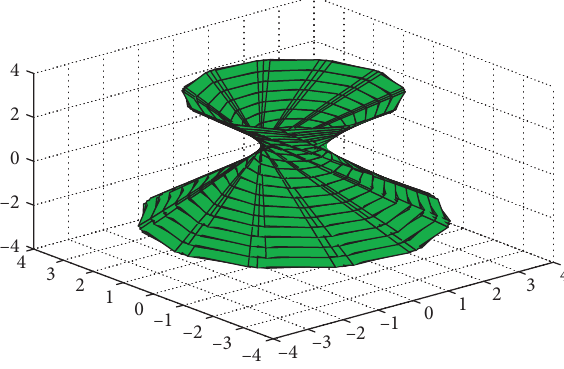
Figure 1: NC-smarandache ruled surface (31).